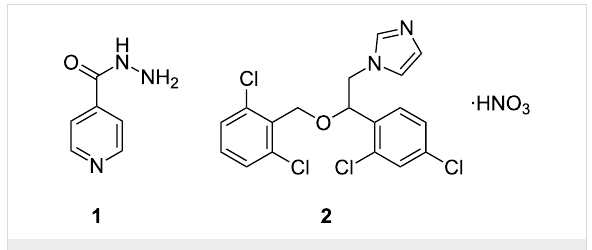
Figure 1: Molecular structures of INH ( 1 ) and ISN ( 2